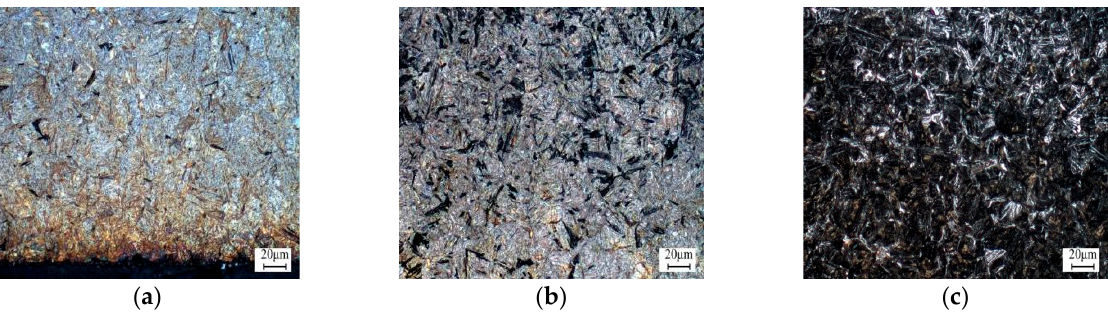
Figure 9. Microstructure of different parts after vacuum carburizing. ( a ) Surface; ( b ) Sub-Surface; ( c ) Center.